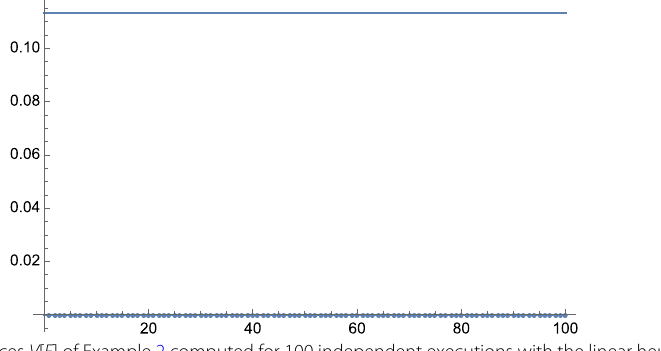
Fig. 7 The variances V [ F ] of Example 2 computed for 100 independent executions with the linear heuristic, using a total of 100 samples for each technique. The horizontal lines correspond to the optimal and equal sampling budget variances, respectively